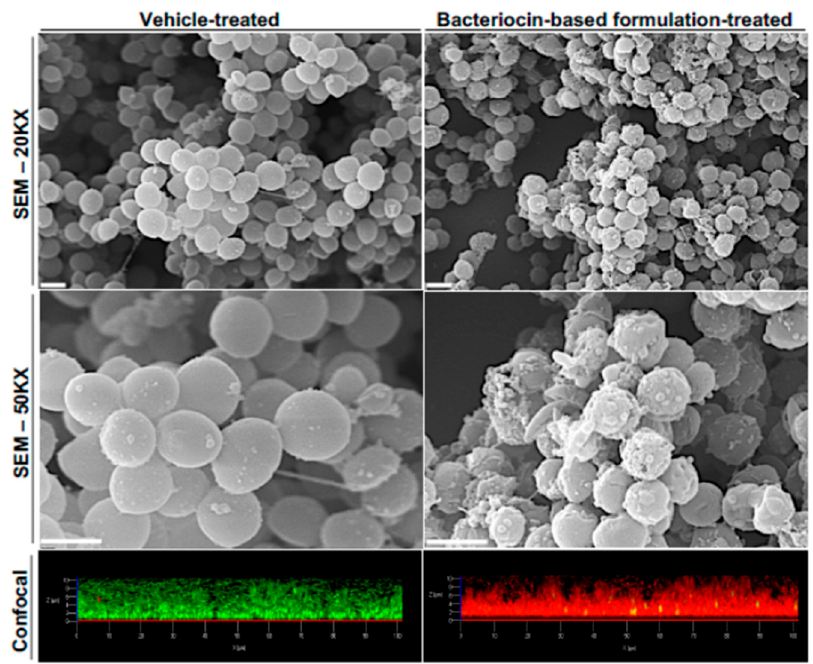
Figure 3. Visualization of the effects of a bacteriocin-based formulation on MRSA